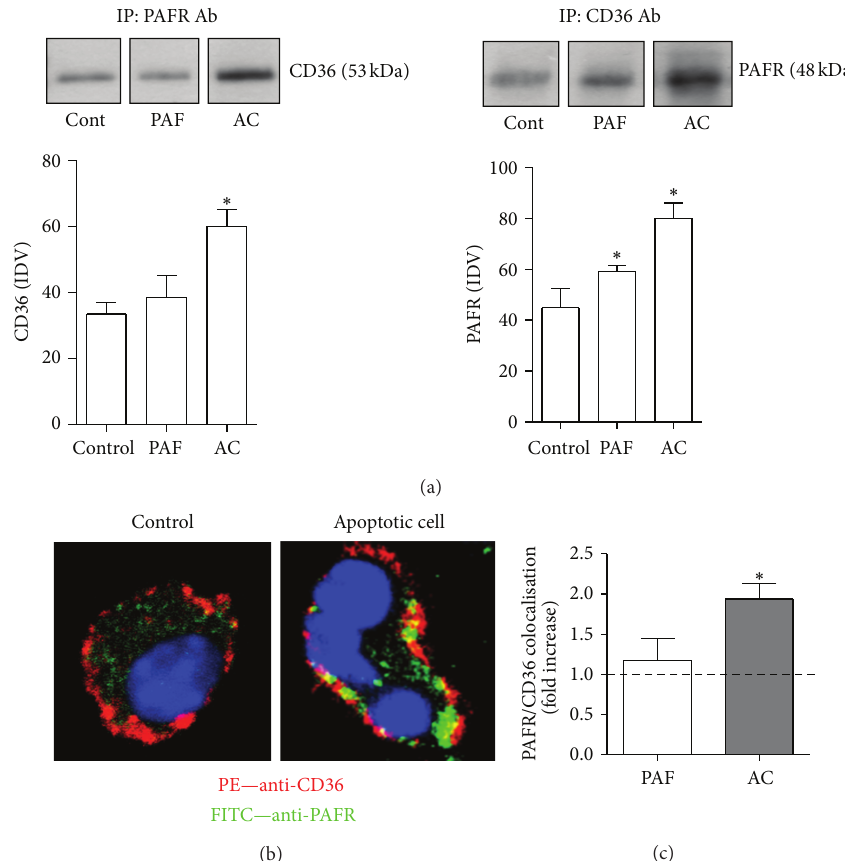
Figure 2: Colocalisation of PAFR and CD36 occurs during efferocytosis. BMDM were treated with PAFR agonist (PAF, 10 −7 M) or apoptotic thymocytes (10 per macrophage) for 20 min to assess coimmunoprecipitation and colocalisation of PAFR and CD36. After washing, cells were lysed and subjected to immunoprecipitation and immunoblotting as described in Section 2, using antibodies to CD36 and PAFR (a). Another group was subjected to fixation prior to staining with anti-PAFR and anti-CD36 primary antibodies, followed by FITC- and PE-labelled secondary antibodies, respectively, and visualised by confocal microscopy as described in Section 2 (b). Quantification of colocalisation (c) was performed using Pearson’s coefficient and JACoP/ImageJ software, and data are presented as mean ± SEM of 15 pictures from three independent experiments ( ∗ 𝑃 < 0.05 versus vehicle). Protein expression was quantified by the AlphaEaseFC software v3.2 beta (Alpha Innotech). The autoradiographs show one representative experiment, and graph data are presented as mean ± SEM of three experiments ( ∗ 𝑃 < 0.05 versus